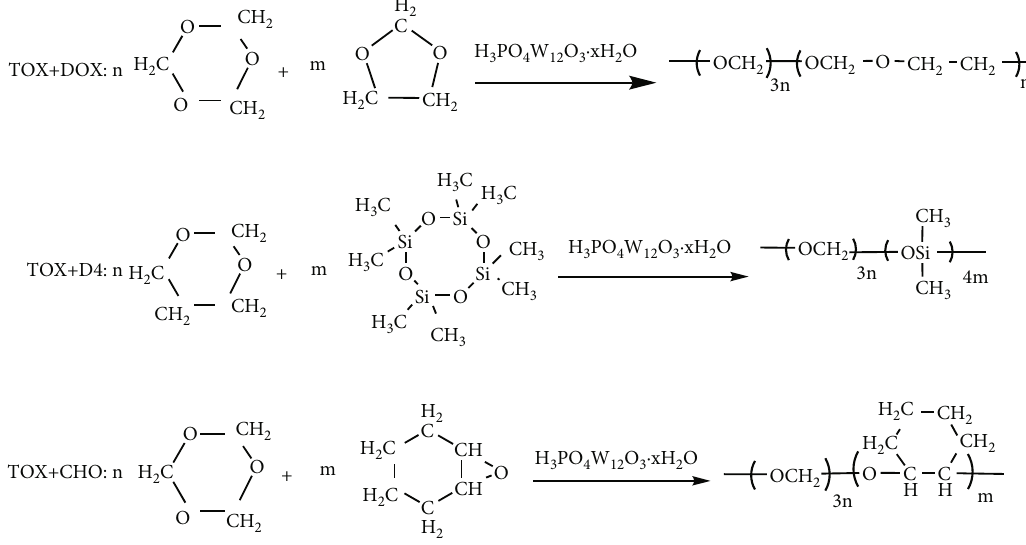
Scheme 1: Copolymerization of TOX with the second monomer. Table 1: 1 H-NMR results of copolymerization of TOX with the second